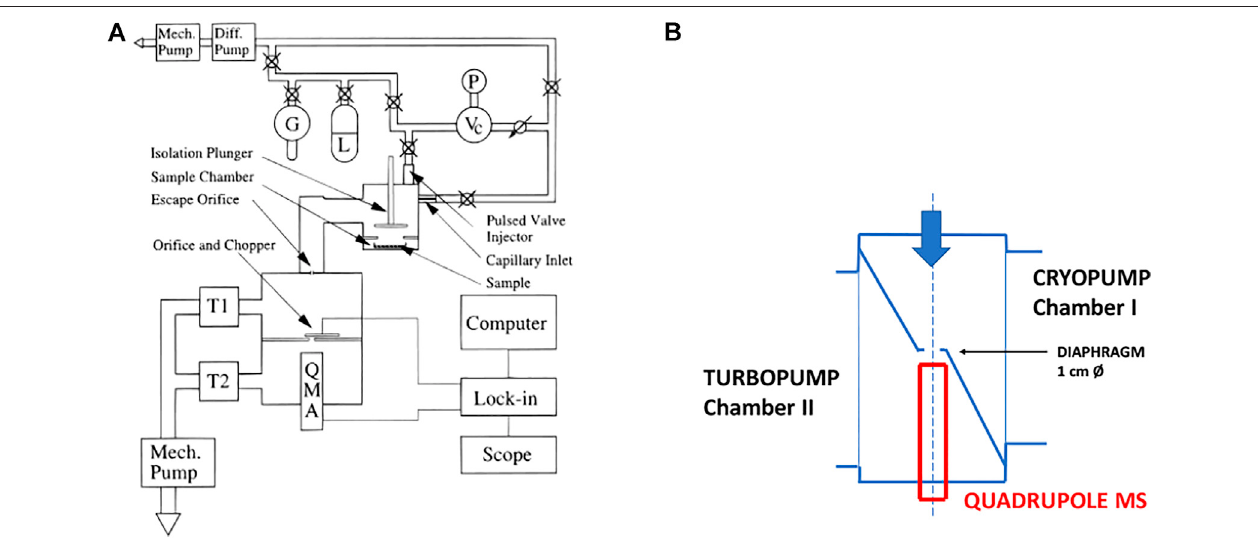
FIGURE 1| (A) (left): Schematic ensemble viewof KFR fl owing gas experiment for measurementof heterogeneous reactions(Fenter et al., 1994).G gas sample, L liquid sample, P pressure gauge, V c calibrated volume, T1 Cryopump (nominal 10 ″ intake fl ange), T2 Turbopump (nominal 6 ″ or 8 ″ intake fl ange). Both pumps have a gatevalvemountedbetweentherespectivechambersandthepump.IncontrasttowhatisshownintheFigurethemechanicalchopperismountedontopoftheQMAin the lower vacuum chamber. (B) (right): Actual structure of cylindrical pumping chamber of KFR with axis in the middle (broken line) enabling the mounting of two largeintakearea fl angesandminimizingthedistancebetweentheupperopeningofthedetectionchamberandtheinletori fi